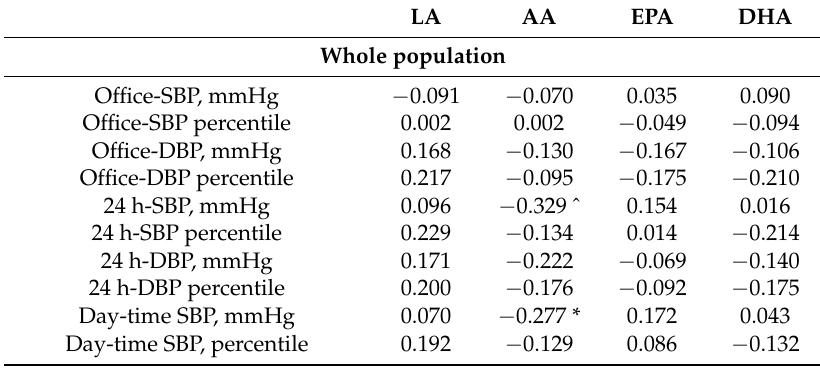
Table 3. Correlations between red blood cell membrane fatty acids and BP in the whole study population and in the subgroups of HBP and NBP obese children.